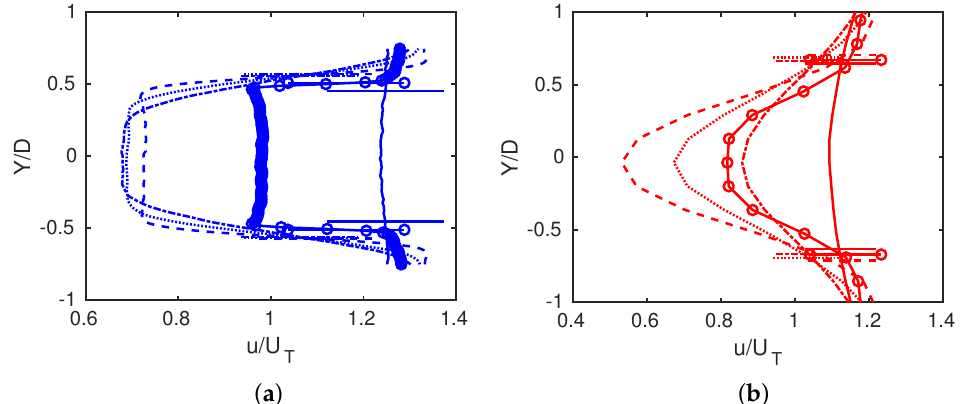
Figure 16. Comparison of streamwise velocity profiles in the horizontal ( x − y ) plane at hub height = 1.33. ( a ) isolated actuator disk. ( b ) wind farm. In each group, solid lines = 1 diameter for C (cid:48) T upstream, circles = at actuator disk, dashed = 1 D downstream, dotted = 2 D downstream, dot-dash = 3 D downstream. Horizontal lines indicate the width of the streamtube at different locations downstream.